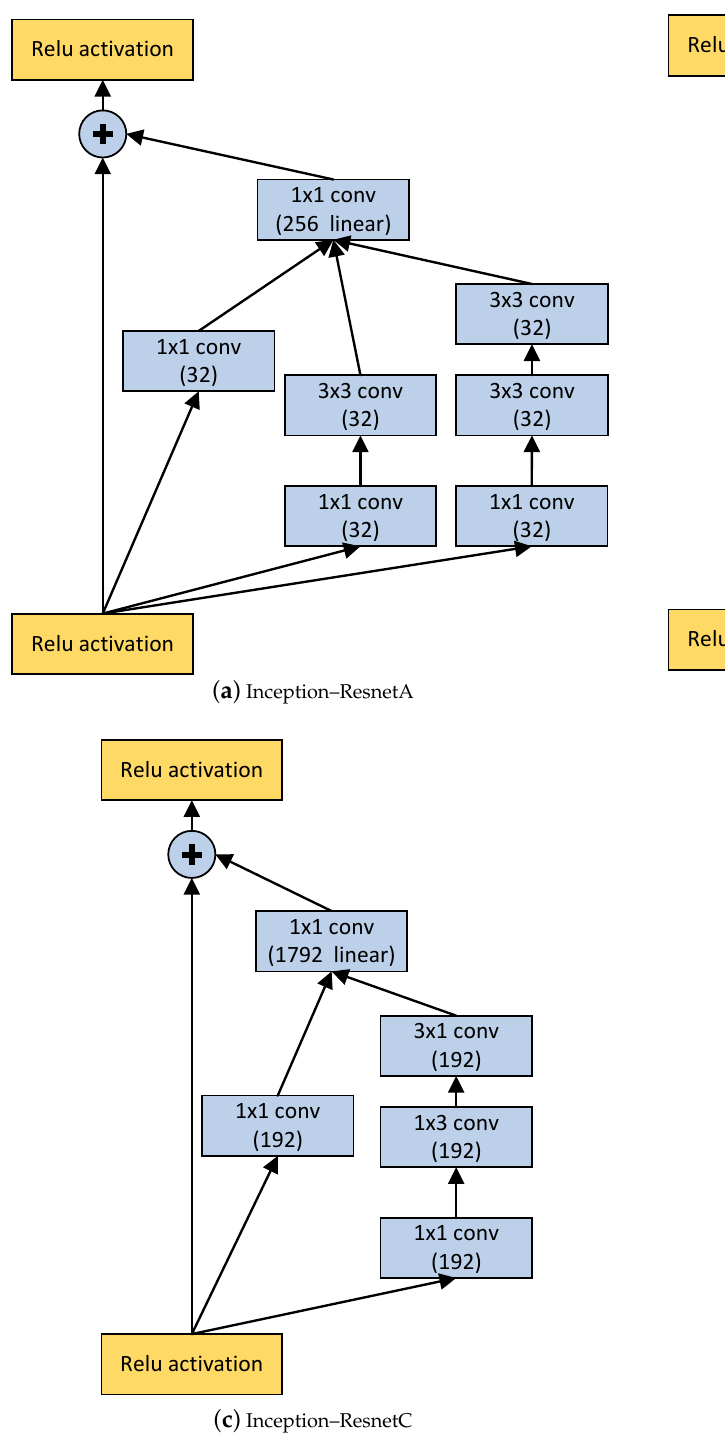
Figure 9. The schema for the three Inception–Resnet modules of the teacher